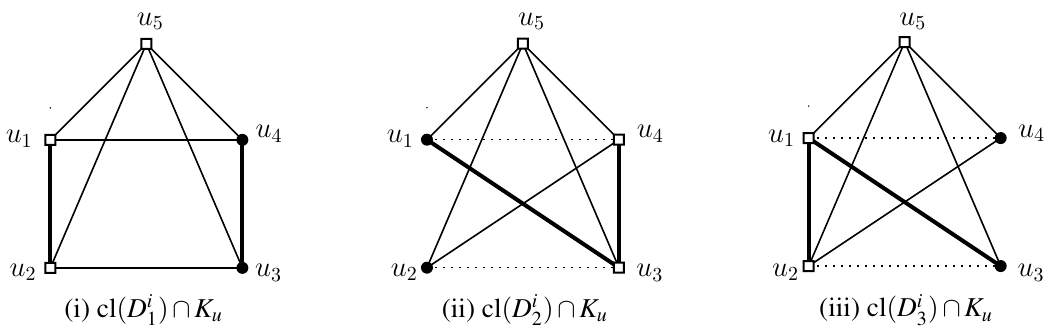
) ∩ K u for 1 ≤ j ≤ 3 (at most one dotted edge may exist in each graph). Figure 9: cl ( D i j